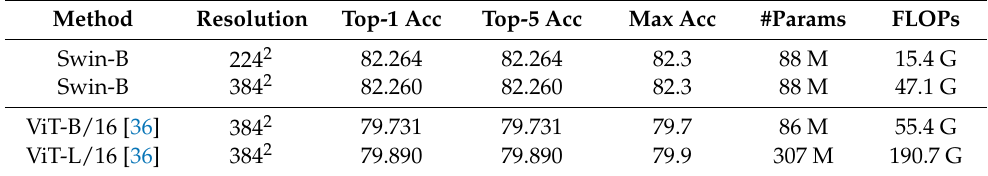
Table 3. Comparison of different backbones in pre-training and fine-tuning on LUNA16 classification.